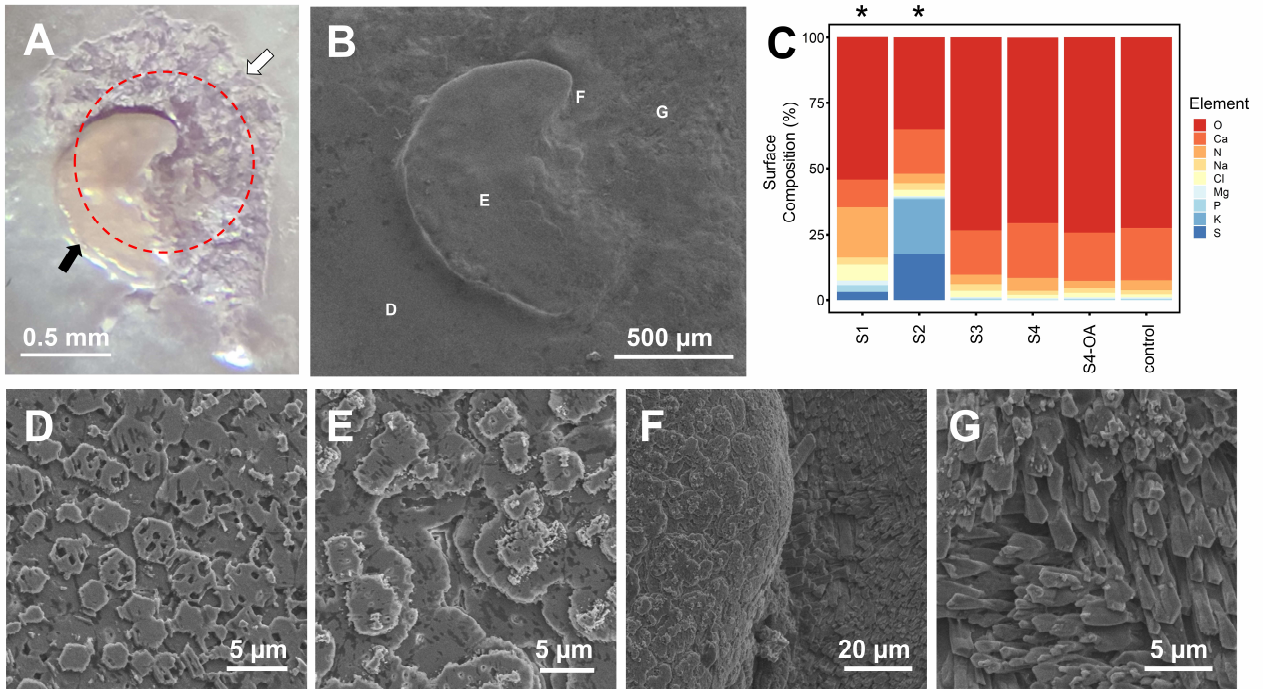
Figure 7. Light ( A ) and SEM ( B , D – G ) microscopy images of a repaired drill hole (( A ), red circle) from the valve interior of a mussel ( M. trossulus ) exposed to 2500 µatm p CO 2 for 10 weeks, with evidence of repaired shell at both Stage 3 (S3; white arrow) and Stage 4 (S4; black arrow). ( C ) Elemental composition (%) of the interior valve shell surface at each repair stage (S1–S4; 400 µatm p CO 2 ), S4 shell produced under ocean acidification for 10 weeks (S4-OA; 2500 µatm p CO 2 ), and unrepaired shell (control) as determined through energy-dispersive X-ray (EDX) spectroscopy analysis (100 µm 2 scan area; n = 3 mussels per group). SEM images of unrepaired ( D ) and S4 repaired shell ( E ) confirmed the presence of a nacreous layer, although with different surface topographies. ( F ) SEM image of the transition between S4 (left) and S3 (right) repaired shell. ( G ) SEM image of S3 repaired shell resembling the calcite crystals commonly found in the oblique prismatic layer. Letters D–G within panel B indicate the locations of images within panels D–G. Asterisks indicate stages where the elemental composition was statistically different from that of the control.